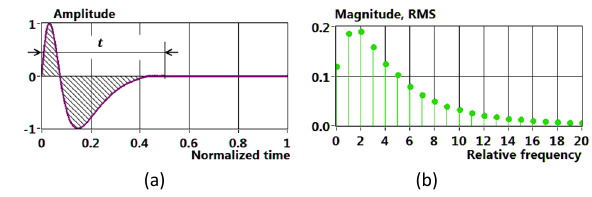
Fig.3: Waveform (a) and magnitude spectrum (b) of the exponentially modulated short chirp with relative duration t = 0.5.